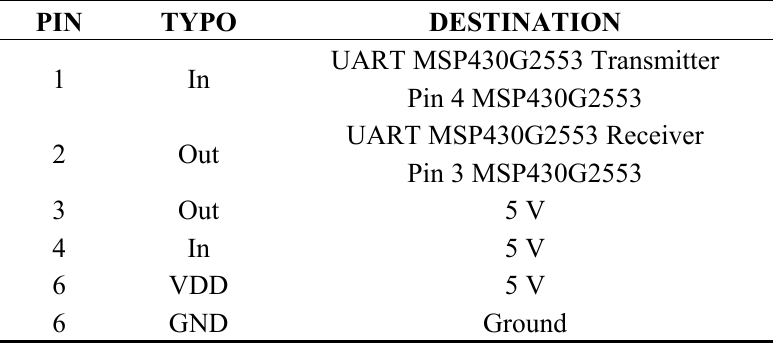
Table 2. Connecting pins on the RN-42-SM.